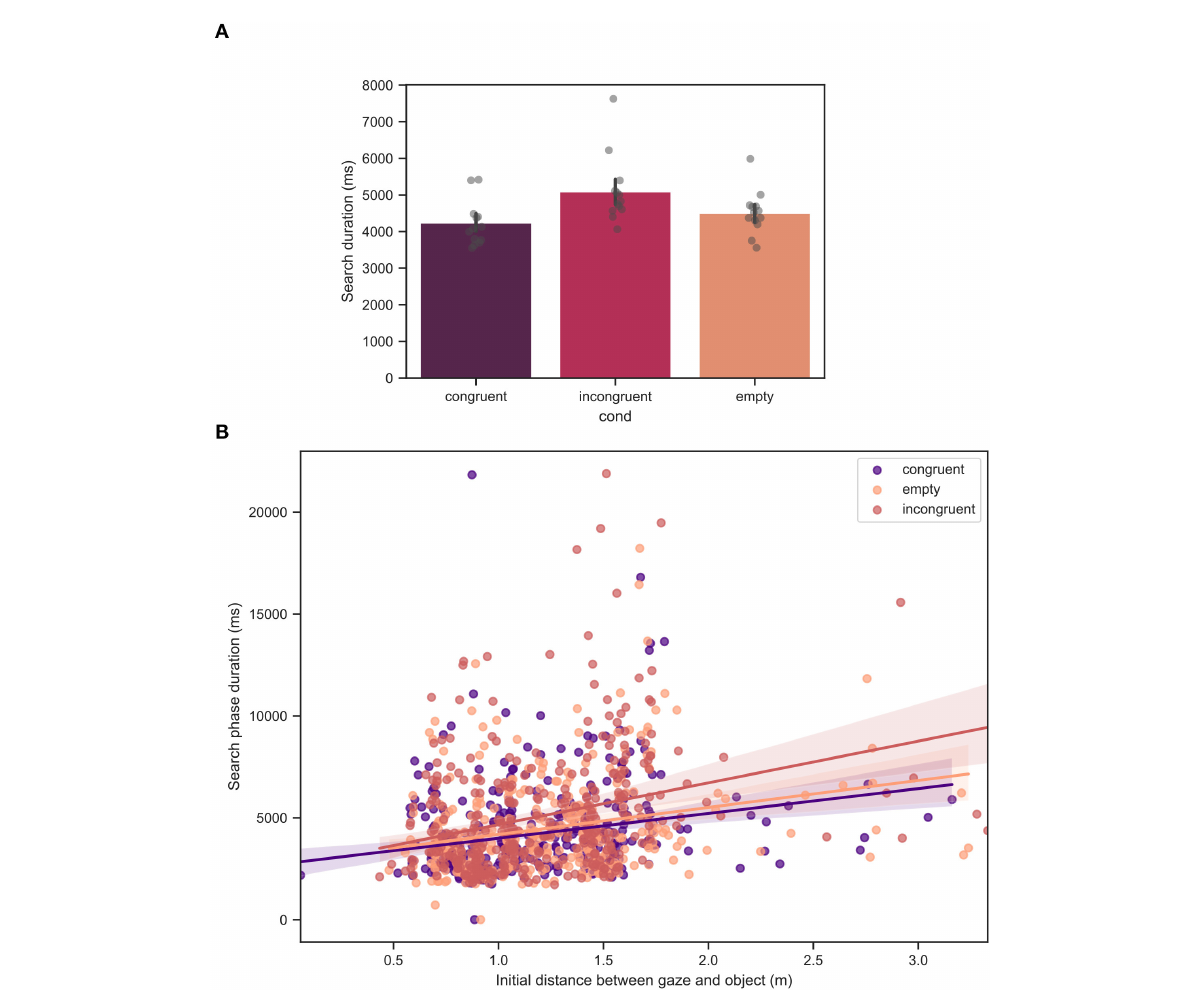
FIGURE8 (A) Mean search duration across all trials for all measured participants. Each bar corresponds to a separate experimental condition. The error bars indicate confidence intervals of 95% computed using bootstrapping (see main text). The individual points correspond to the mean value for each individual participant. The difference between the congruent and incongruent conditions was significant with p < 0.001. The difference between the congruent and empty conditions was not significant. (B) Mean search duration as a function of the initial gaze-object distance, defined as the distance between the looked at point and the target fixation at the beginning of the trial. The straight lines are linear fits to the data. The effect of the initial gaze-object distance was significant with p < 0.001.